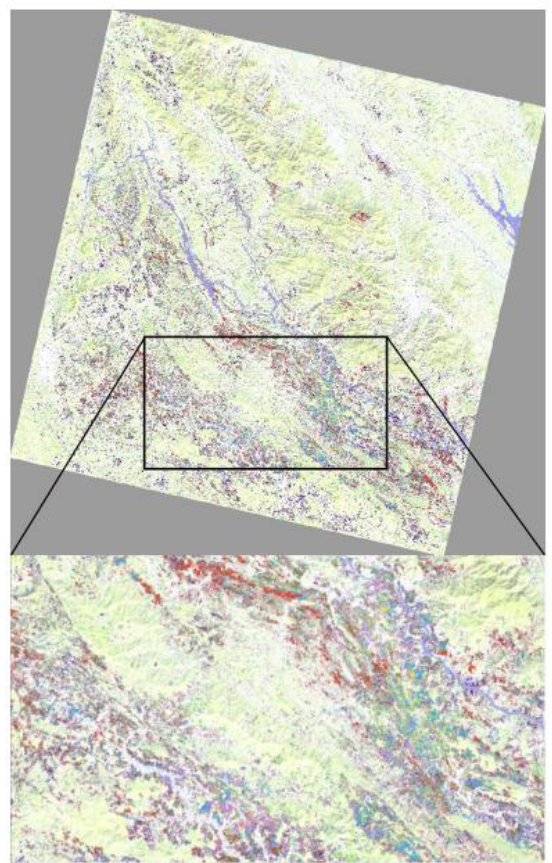
Figure 6. Map of crop types and window for detail visualization. There are 14 crop types dyed by colours in Table 2. Blurred background image is made by Landsat 8 colour composite RGB: